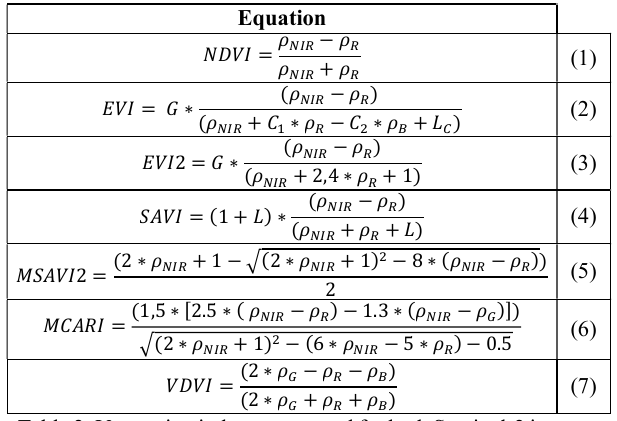
This contribution has been peer-reviewed. The double-blind peer-review was conducted on the basis of the full paper. https://doi.org/10.5194/isprs-annals-V-3-2020-453-2020 | © Authors 2020. CC BY 4.0